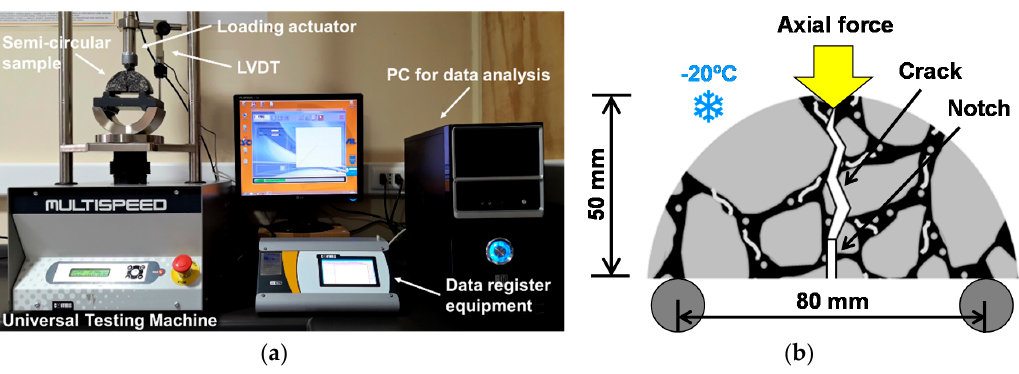
Figure 2. ( a ) Three-point bending test on asphalt mixture semi-circular samples; and ( b ) schematic representation of the broken test sample.